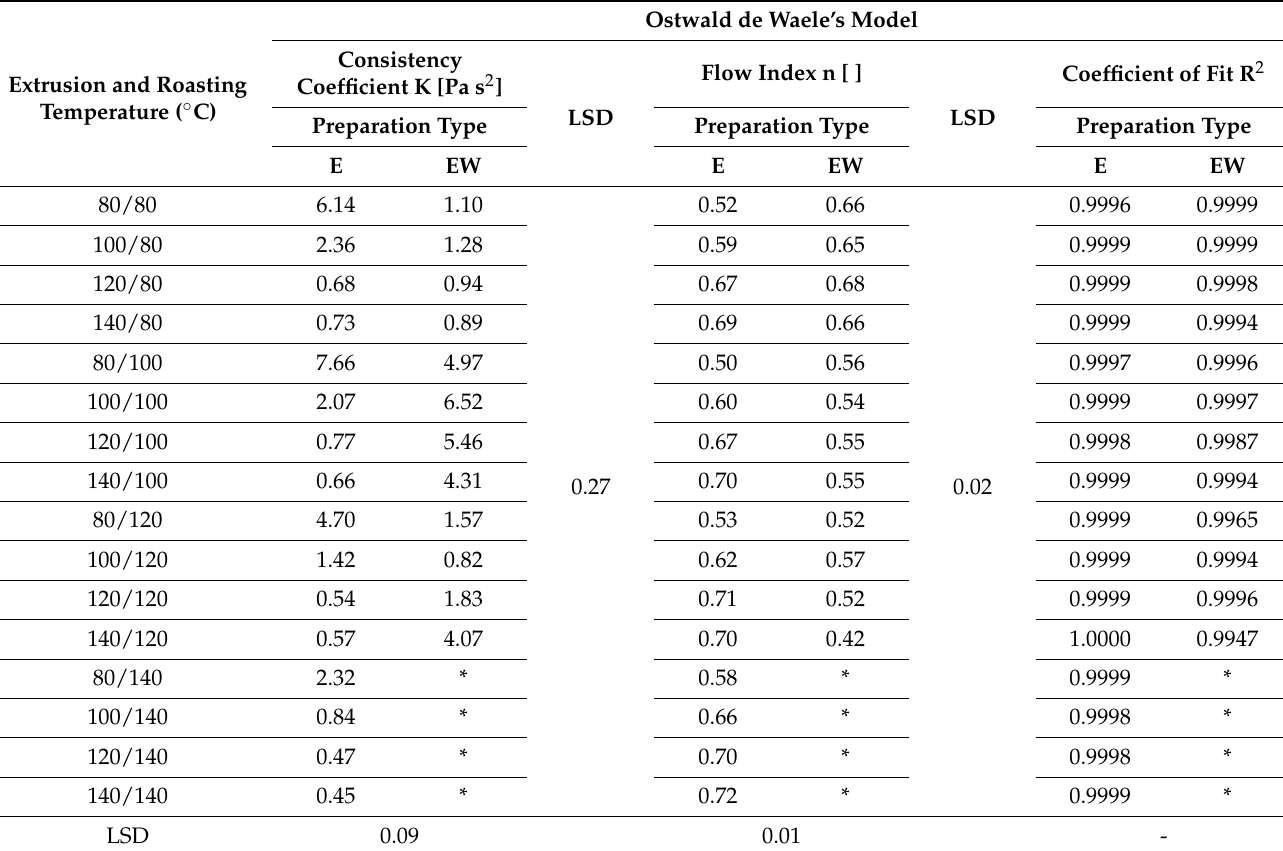
Table 2. Parameters of Ostwald de Waele’s model characterizing the rheological properties of pastes made from extruded and roasted starch (E) and from starch extruded with apple distillery wastewater and roasted (EW).